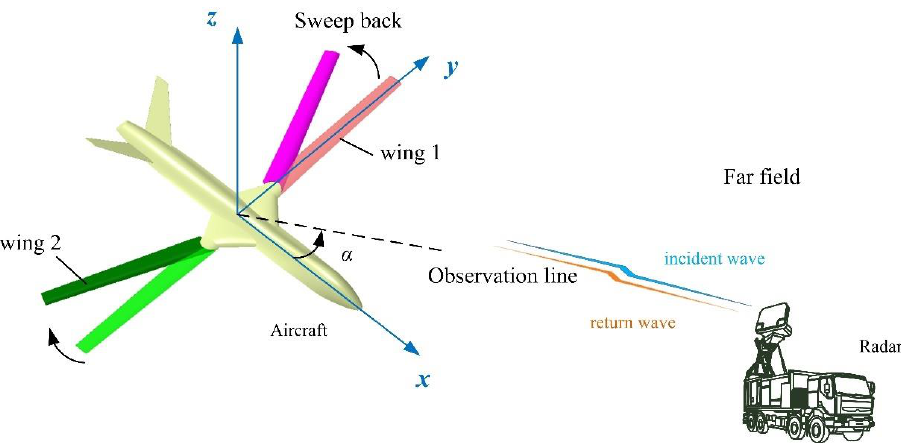
Figure 3. Schematic of electromagnetic scattering of an aircraft with a variable swept-back wing. The surface of the model divided by triangular facets can be obtained in the following